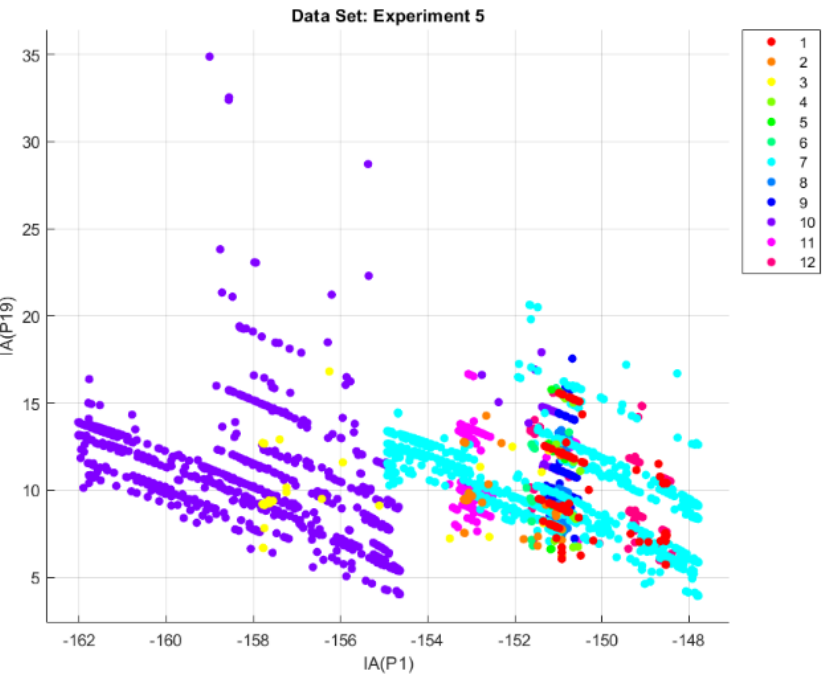
Figure 17. Data set of experiment 4.